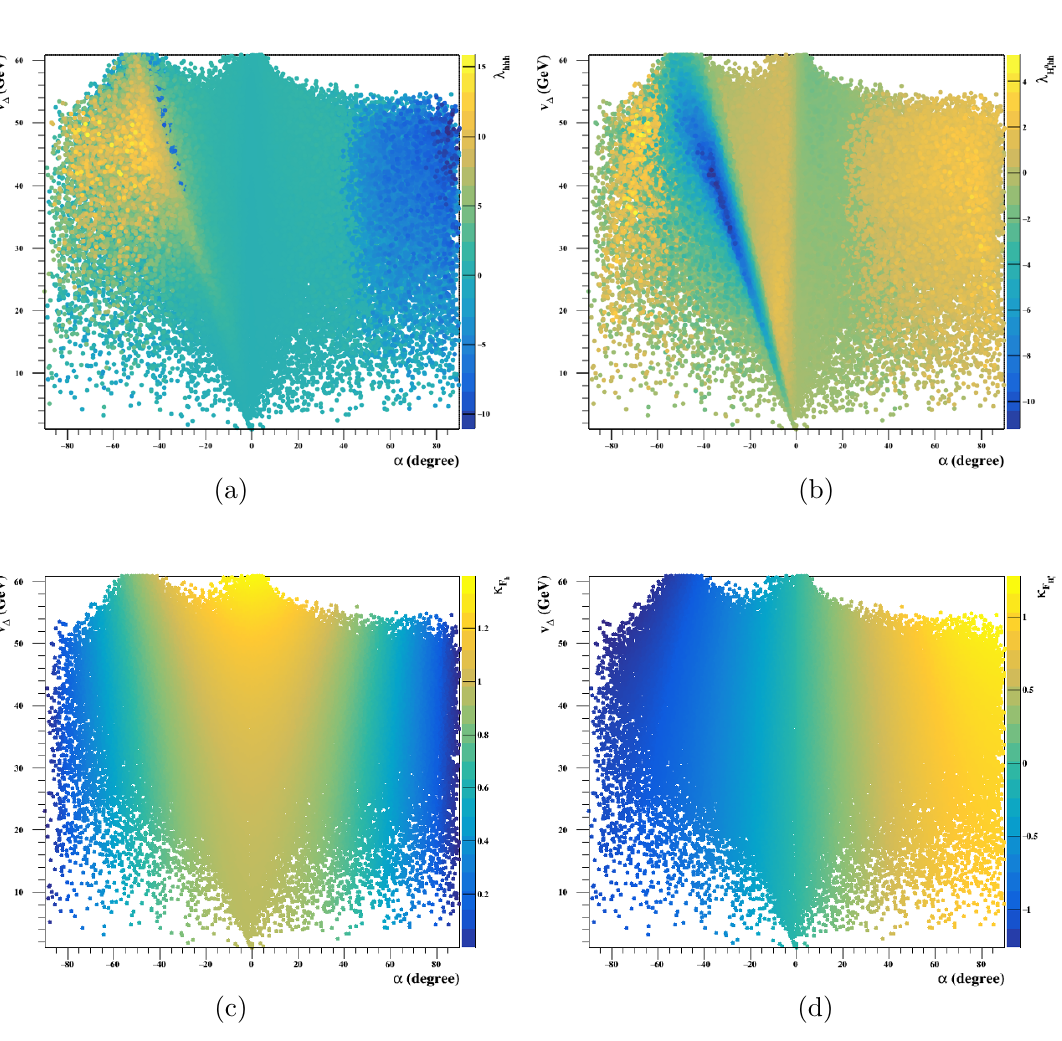
Figure 2 . Couplings of h and H 0 in the (cid:11) - v (cid:1) plane, with m 1 show respectively (cid:21) hhh and (cid:21) with maximally allowed absolute value. Plots (c) and (d) give H 0 1 hh respectively (cid:20) F and (cid:20) F h H 0 1